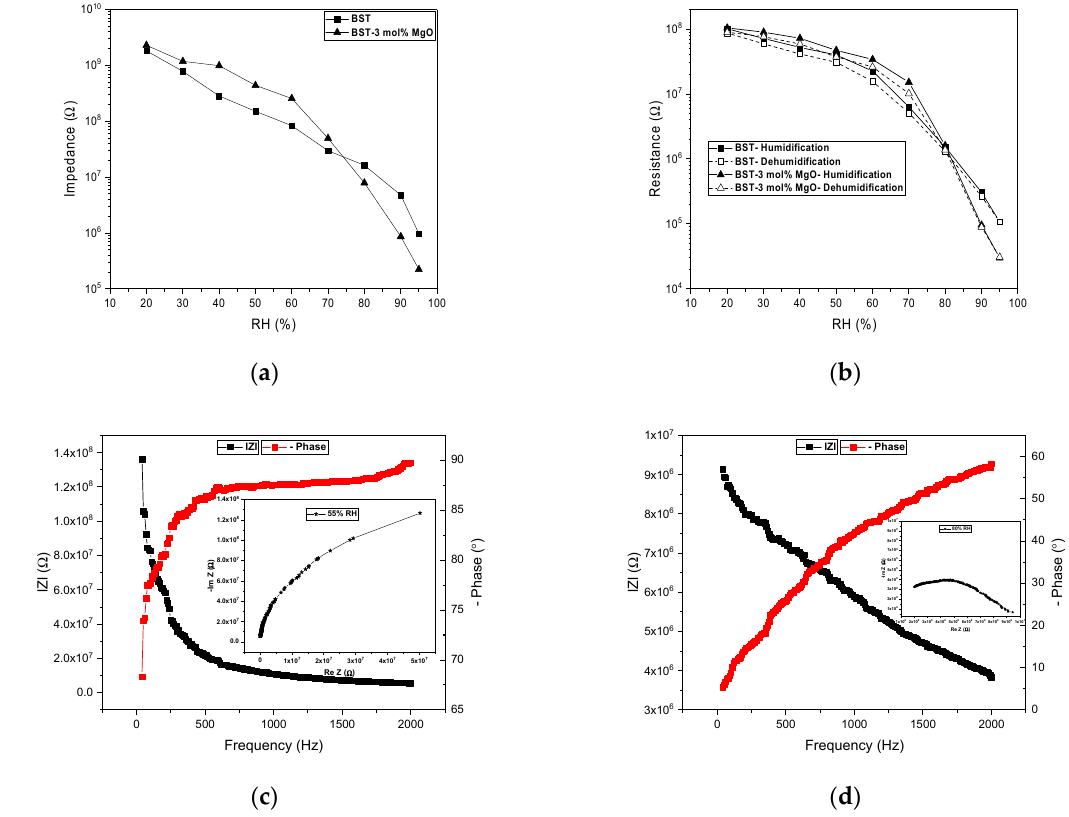
Figure 2. ( a ) Comparison of impedance change of the sensors; ( b ) hysteresis characteristics of the sensors measured at 10 KHz; ( c ) Bode and Inset Nyquist plot of the real and imaginary part of the impedance at 55% RH; ( d ) Bode and Inset Nyquist plot of the sensor at 80%